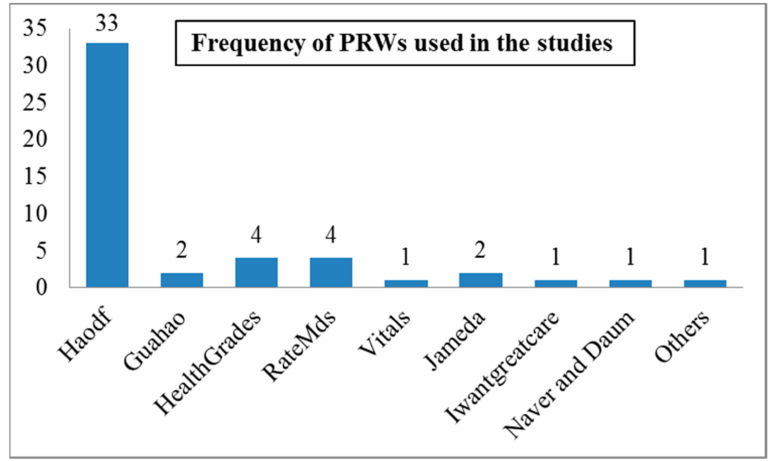
Figure 4. Physician rating websites used in